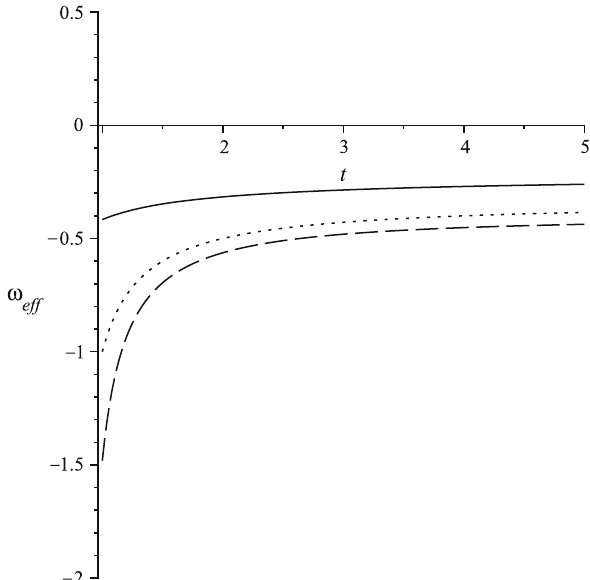
Fig. 2 The figure shows the qualitative behavior of effective state parameter of holographic dark energy for − 1 / 3 > ω 1 > 0 (solid line), ω = − 1 / 3 (dotted line), and ω < − 1 / 3 (dashed line). It can be seen 1 that for ω < − 1 / 3 at t 0 we have ω eff < − 1, so the holographic